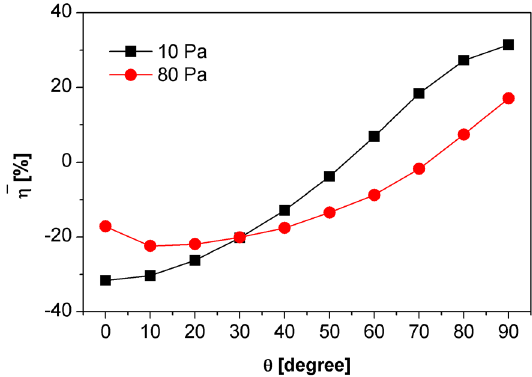
Figure 11 : Dc self-bias as a function of θ in electrically asymmetric dual-frequency discharges operated at 13.56 MHz + 27.12 MHz at 10 Pa, Φ =Φ = 100 V and at 80 Pa, Φ LF HF